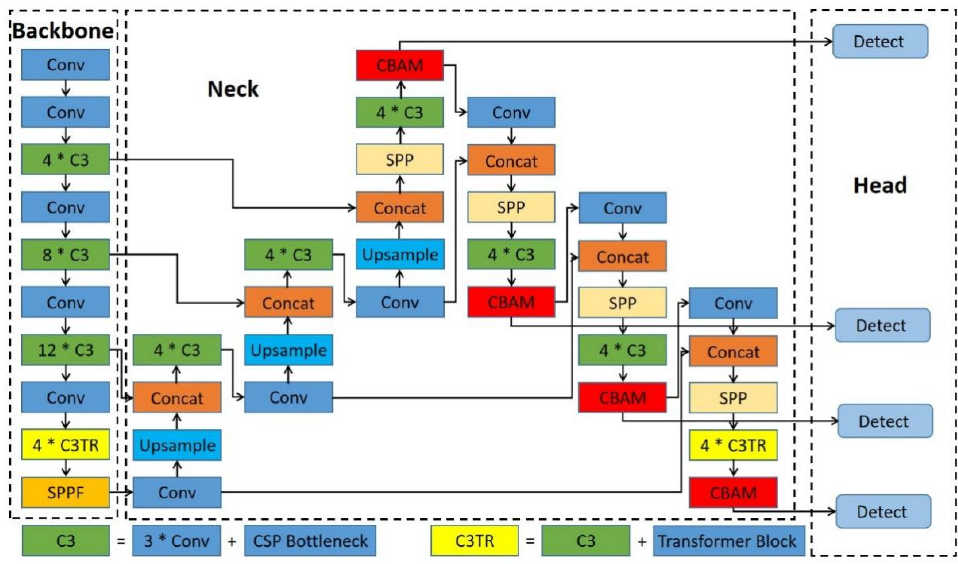
Figure 4. The architecture of the improved TPH-YOLOv5.